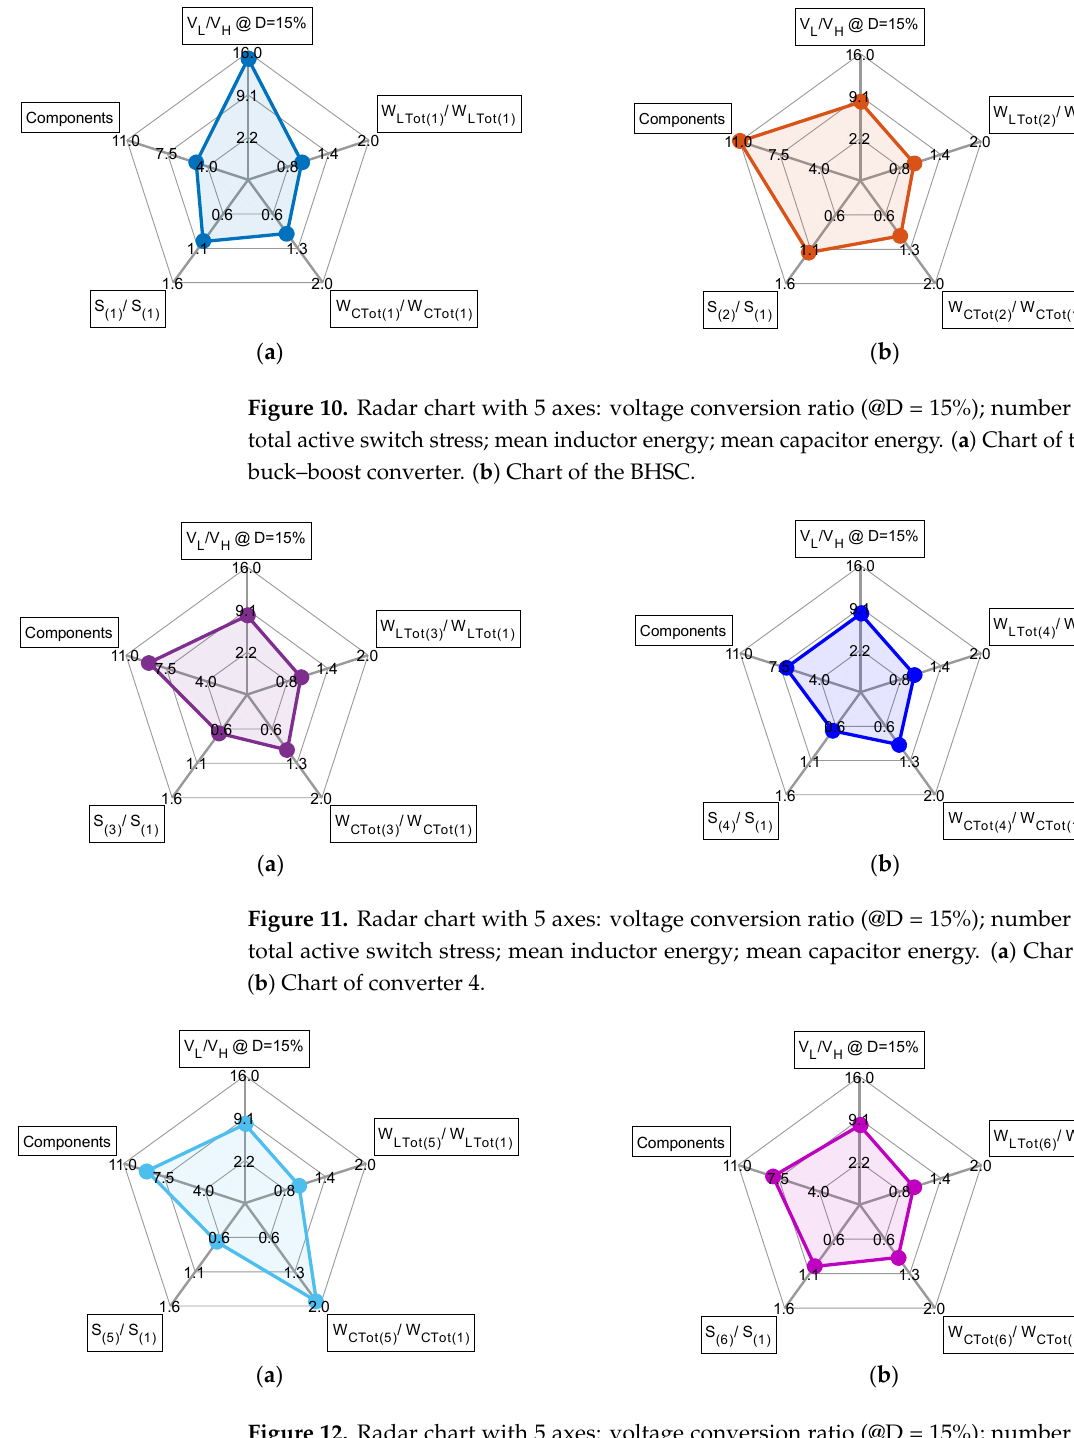
Figure 12. Radar chart with 5 axes: voltage conversion ratio (@D = 15%); number of components; total active switch stress; mean inductor energy; mean capacitor energy. ( a ) Chart of converter 5. ( b ) Chart of converter